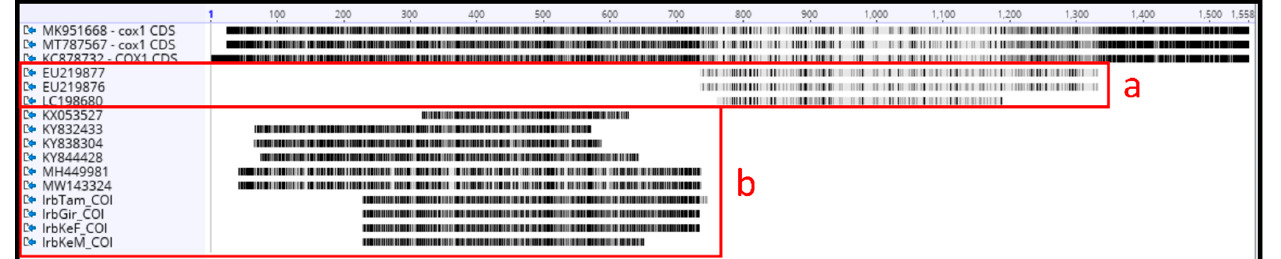
Figure A4. Alignment of sequences EU219876, EU219877 and LC198680 (box a ) against reference COI sequences from Ischnura species (first three sequences in the alignment). Box b shows sequences that correspond with the Folmer region used in barcode analysis, which was the target region of the primers used in our study.